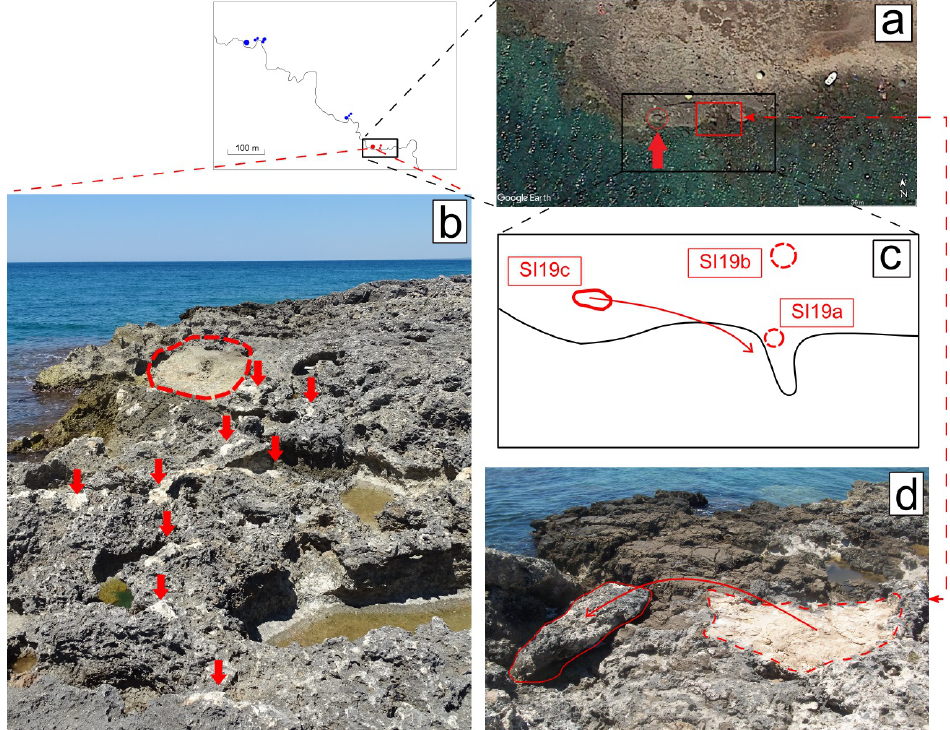
Figure A3. Evidence of geomorphological imprints on the surveyed area of the storm of 12–13 November 2019: ( a ) 2015 Google Earth satellite image with the location of Boulder c; ( b ) drag marks for the sliding of Boulder c (the dashed line marks the pre-storm location); ( c ) the inferred trajectory of c as defined through the field survey; ( d ) the socket and the post-storm location of Boulder b (the supposed saltation movement is also